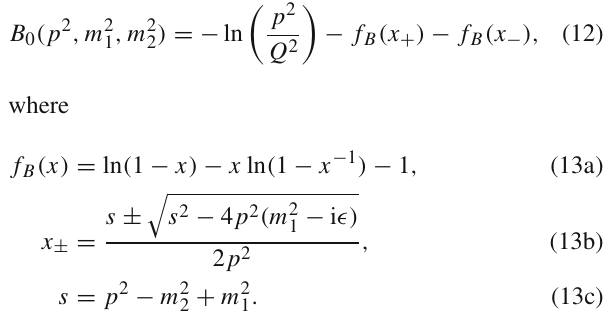
the chosen set of input parameters, { M Z , G F } or { M Z , M W } . This explains the different singularities between Figs.4 and 5. In the following we describe the intricate μ dependence of m 0 and investigate the source of the singularities of m (cid:3)